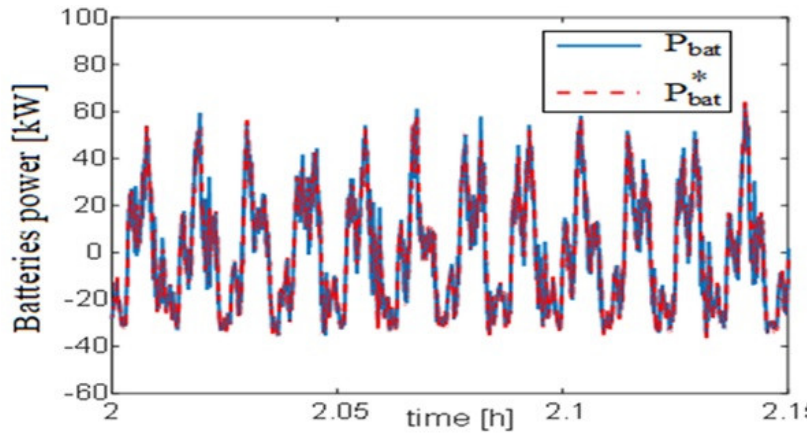
Figure 17. Result of battery power control.